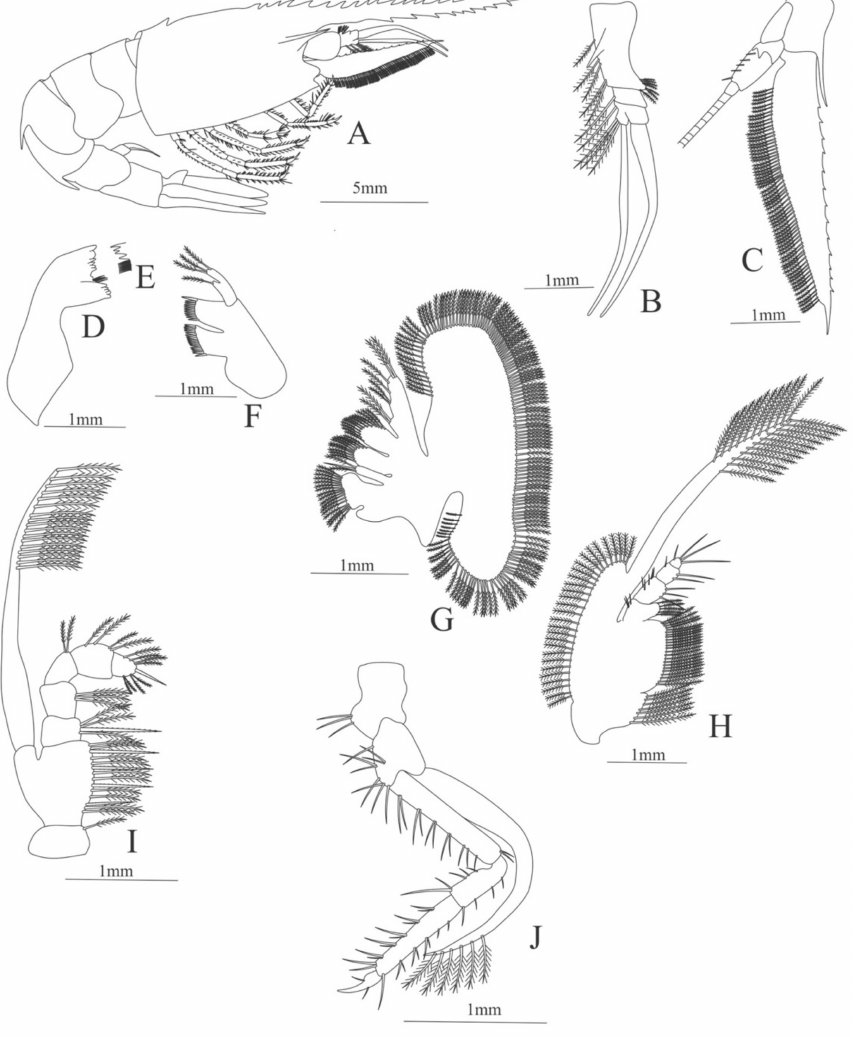
Figure 19. Heterocarpus ensifer : ( A ) lateral view; ( B ) antennule; ( C ) antenna; ( D ) right mandible; ( E ) left mandible (cutting edge); ( F ) maxillule; ( G ) maxilla; ( H ) first maxilliped; ( I ) second maxilliped; ( J ) third